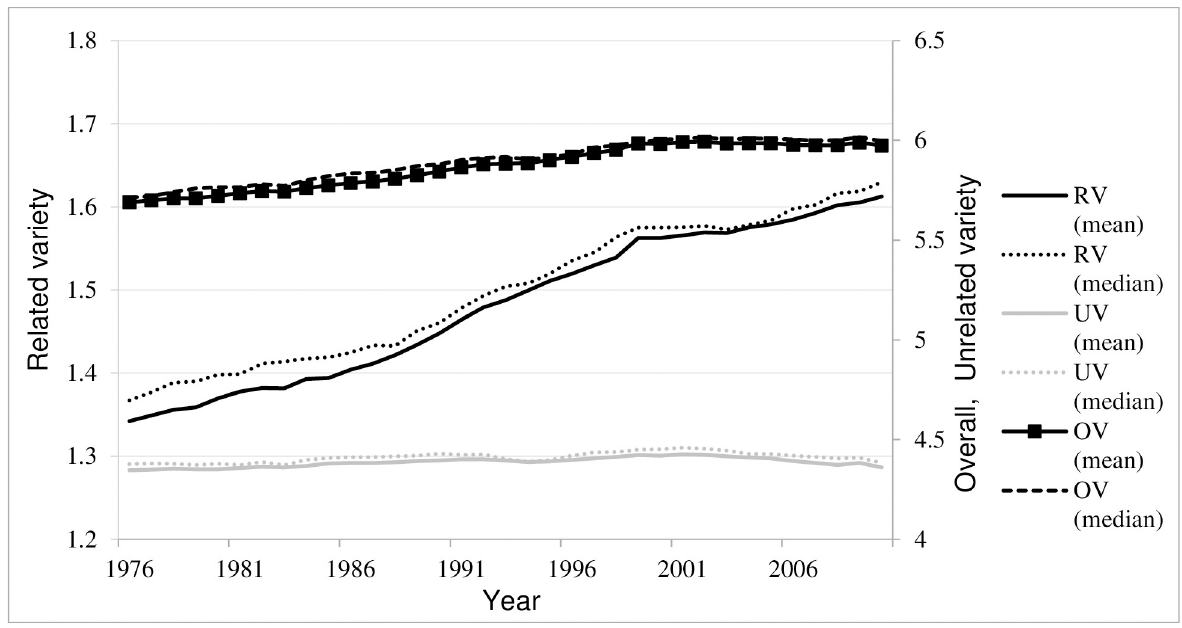
Fig 2. Development of overall, related and unrelated variety over time. Source: Authors.